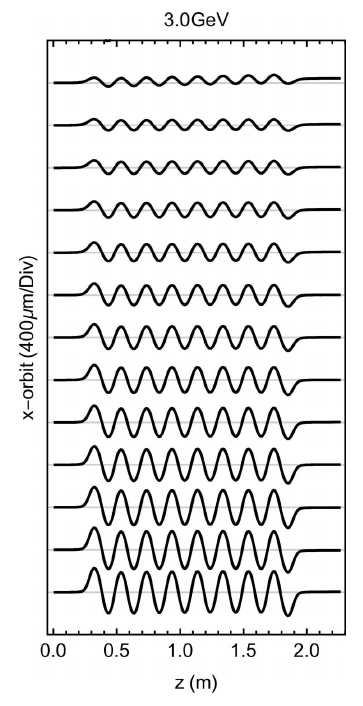
Figure 7 The orbit within the modulator for the operational K range between 8 (top) and 36 (bottom). The orbit is estimated for an electron beam energy of 3.0 GeV.